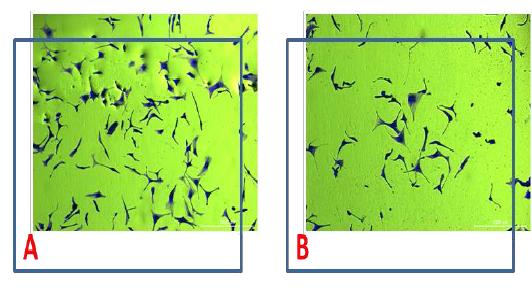
Figure 4. Cells of B16V ; A: Effect of control. B: Effect of 100mcg/ml of compound [IV] at 72